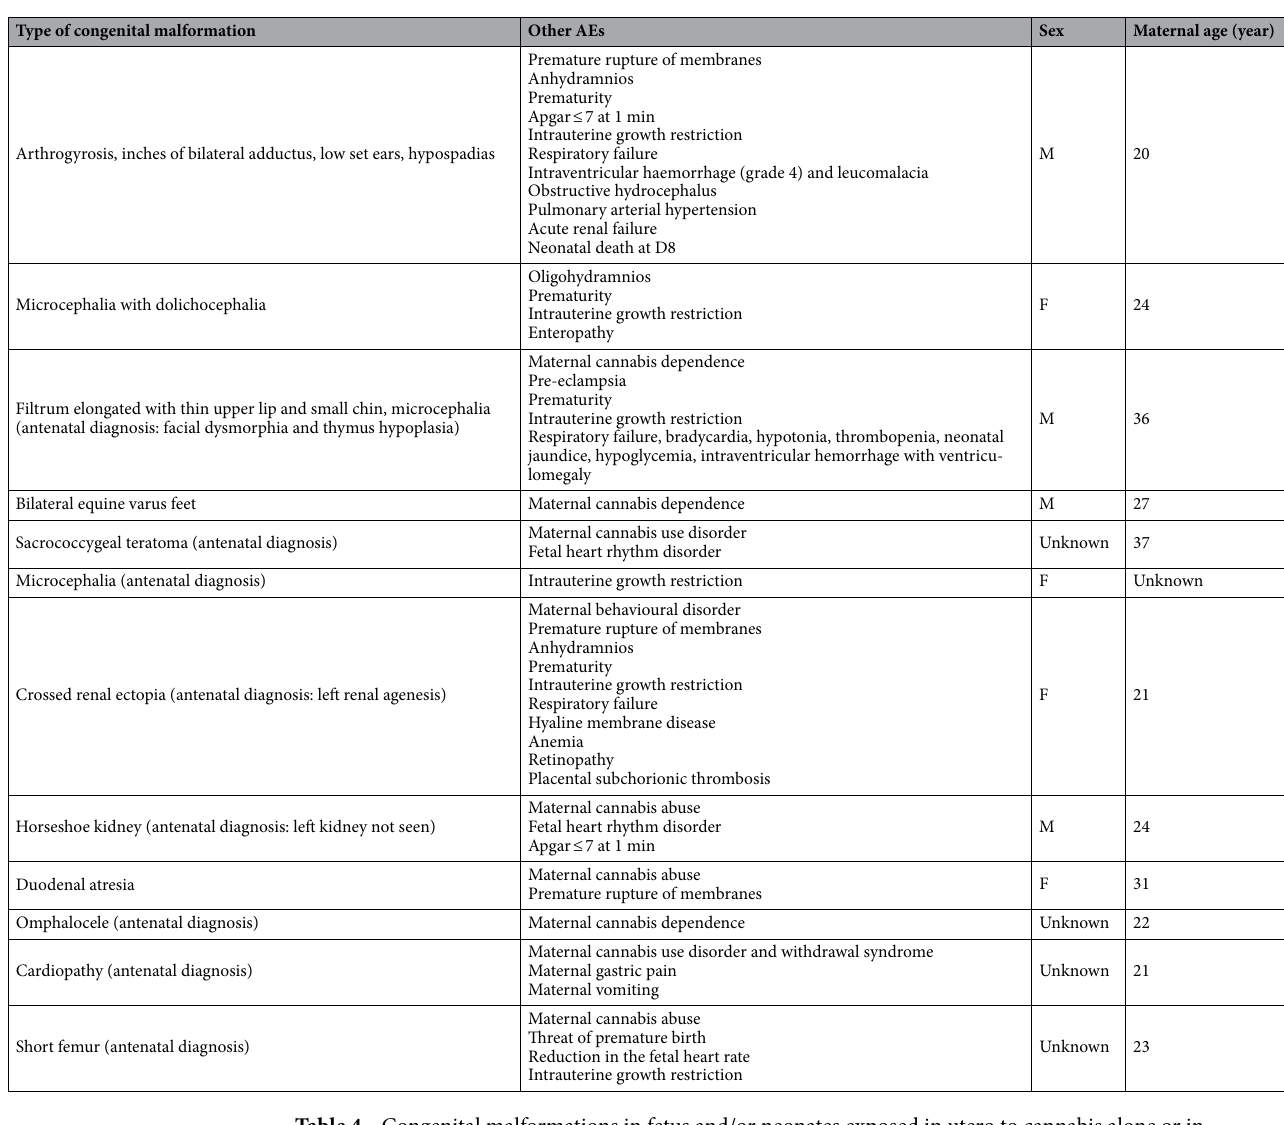
Table 4. Congenital malformations in fetus and/or neonates exposed in utero to cannabis alone or in association with tobacco. D day, M male, F